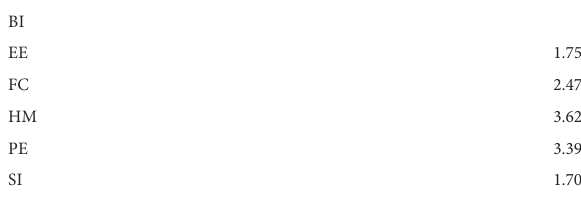
TABLE 5 Internal consistency, construct reliability, and convergent validity.